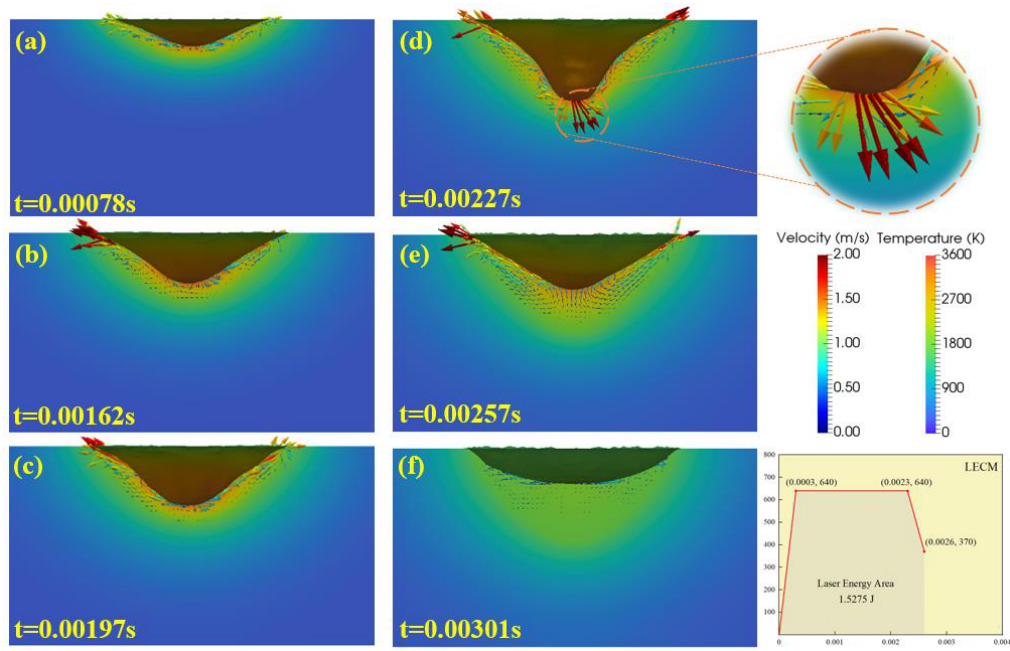
Figure 8. The visual simulation results of the keyhole evolution process in LECM. ( a ) 0.00078 s, ( b ) 0.00162 s, ( c ) 0.00197 s, ( d ) 0.00227 s, ( e ) 0.00257 s, ( f ) 0.00301 s.